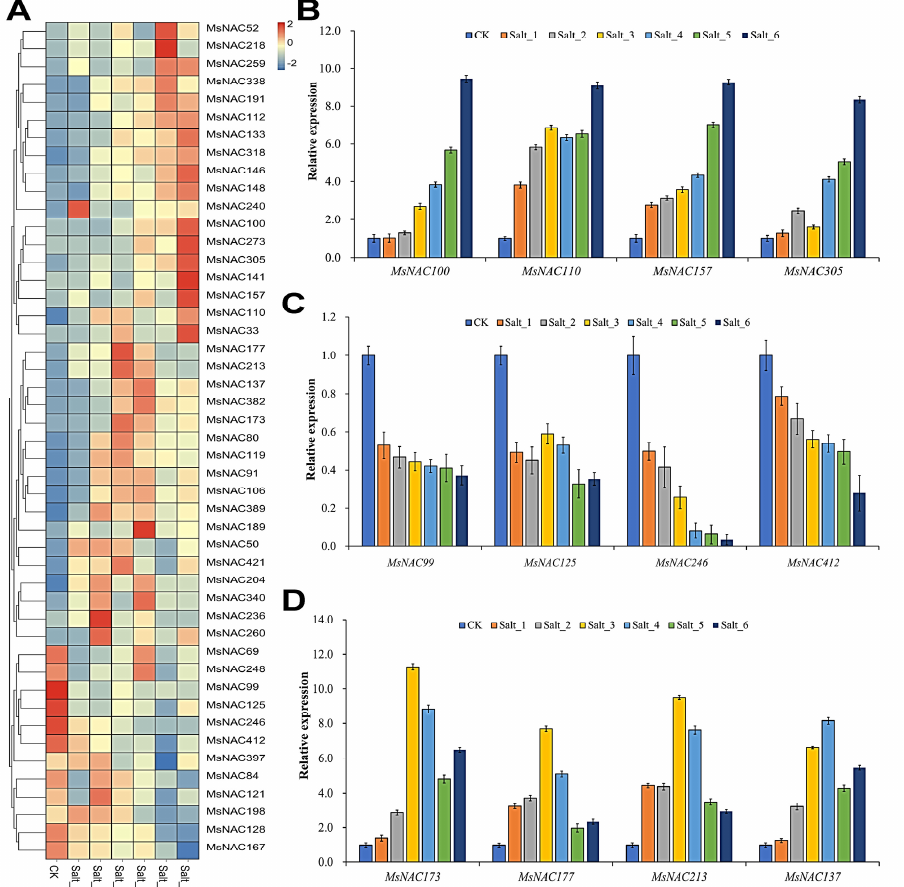
Figure 8. MsNAC genes that respond to salt stress. ( A ), Heatmap of the 47 MsNAC genes that respond to salt stress. The expression levels were normalized by row using the Z-Scores algorithm. The color scale at the right of the heatmap refers to the relative expression level, and the color gradient from blue to red presents an increasing expression level. ( B ), RT–PCR analysis of MsNAC100 , MsNAC110 , MsNAC157 and MsNAC305 . ( C ), RT–PCR of MsNAC99 , MsNAC125 , MsNAC246 and MsNAC412 . ( D ), RT–PCR of MsNAC137 , MsNAC177 , MsNAC213 , MsNAC312 and MsNAC137 . CK was arbitrarily set to 1. Error bars represent the standard deviations of three technical